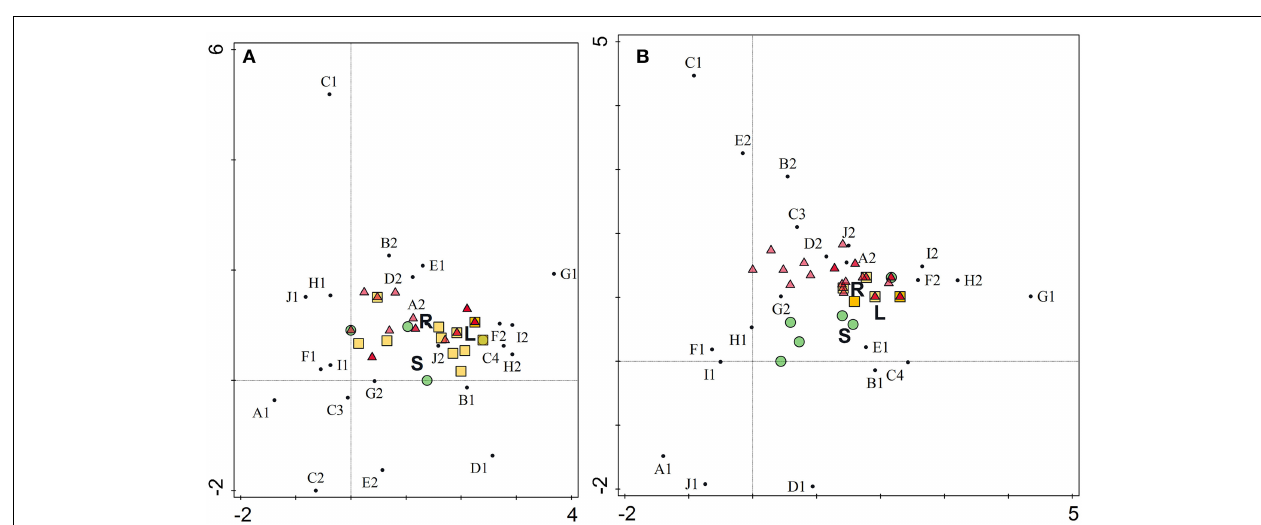
FIGURE 4 | Ordination diagram as an output of detrended canonical correspondence analysis of morphological characteristics of endophytic isolates from hyperaccumulators Astragalus bisulcatus (A) and Stanleya pinnata (B). X axis, DCA axis1; Y axis, DCA axis2. Organ variables are represented by letters (R, root; S, stem; L, leaf), isolates by colored circles (isolates from stems), triangles (isolates from roots) and squares (isolates